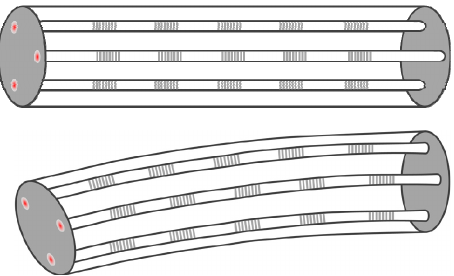
Fig. 5 | Strain measurements in a multicore fiber by using co-located fiber Bragg grating arrays for shape